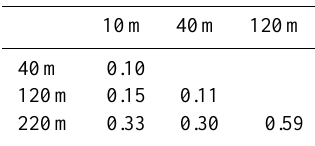
Table 2. Pair-wise CD values at different